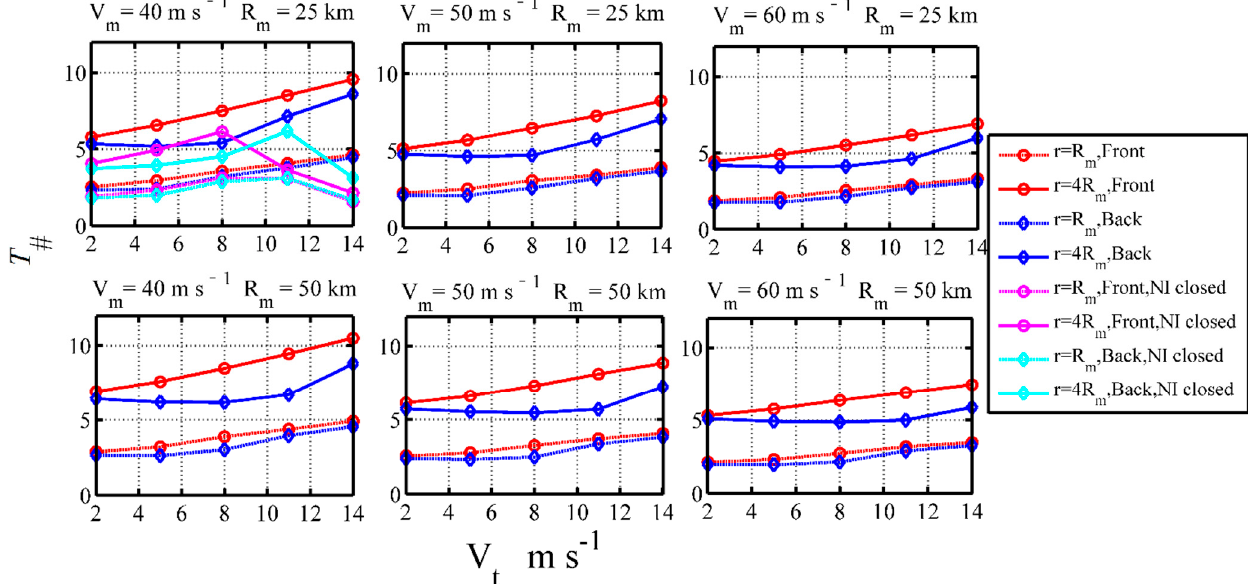
Figure 4. Modelling results of H # . The lines correspond to different radial distances, such as r = R m , and sectors in terms of front or back and model setting with nonlinear interaction (NI) closed or not.